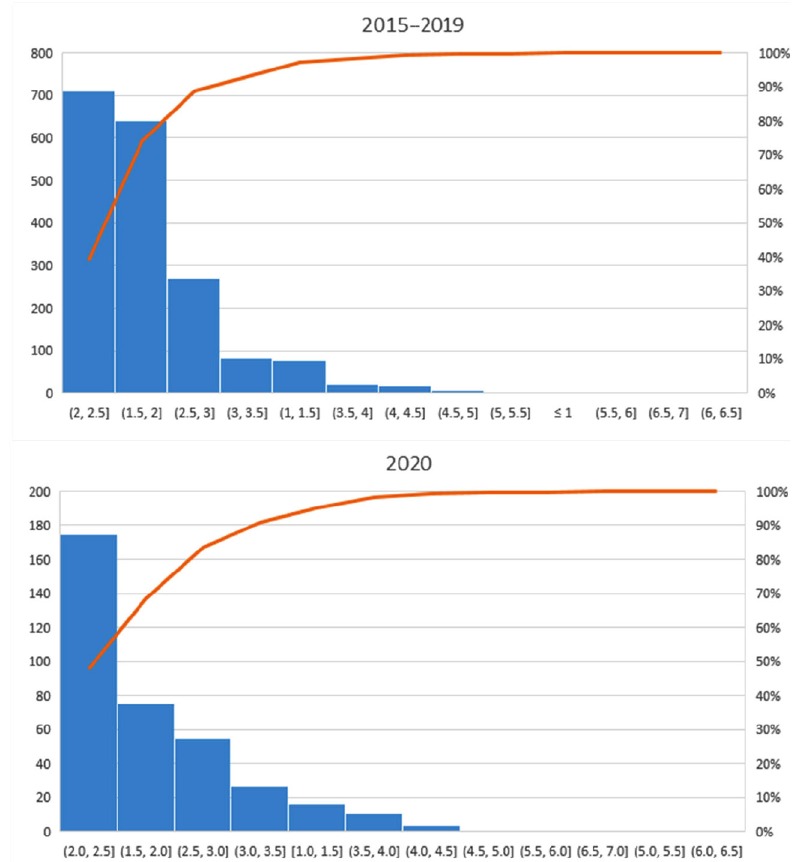
Figure 6. COD/BOD ratio Pareto diagram for 2020 versus